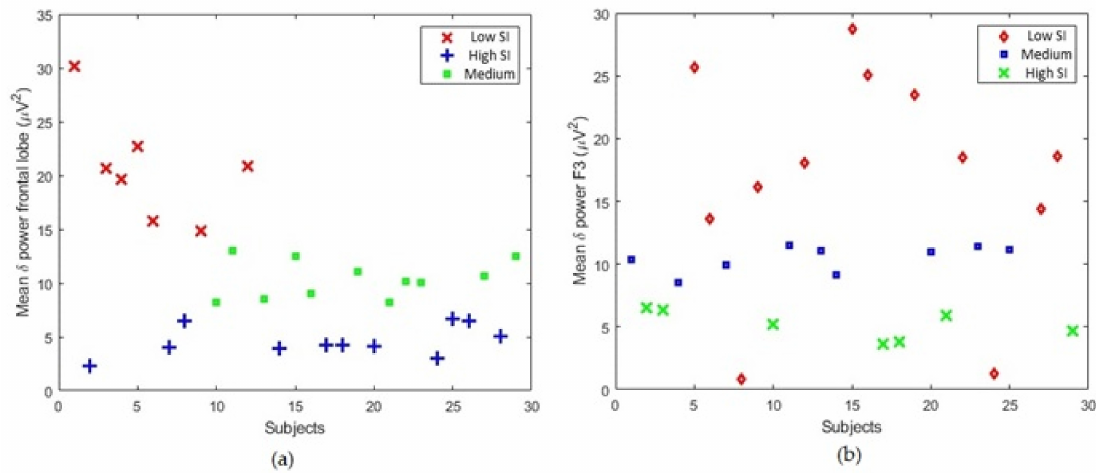
Figure 5. Example of DBSCAN clustering results: ( a ) the clusters are well separated; ( b ) misclasses